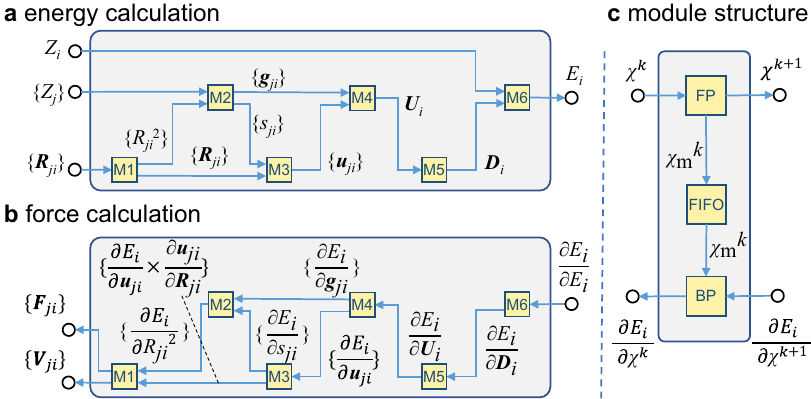
Fig. 8 The implementation of PES calculation. Six modules (i.e., M1, M2, M3, M4, M5, and M6) are used to implement the forward propagation calculation ( a ) from the chemical species Z i and { Z j } and relative coordinates { R ji } to the energy E i as Section Energy calculation. The backward propagation ( b ) of modules is employed to calculate the component of force { F ji } and virial { V ji } as Sectioin Force and virial calculation. Each module can be divided into three submodules ( c ): FP, BP, and FIFO, where FP and BP are used to implement the calculation of forward propagation and backward propagation, respectively; FIFO is employed to transmit data from FP to